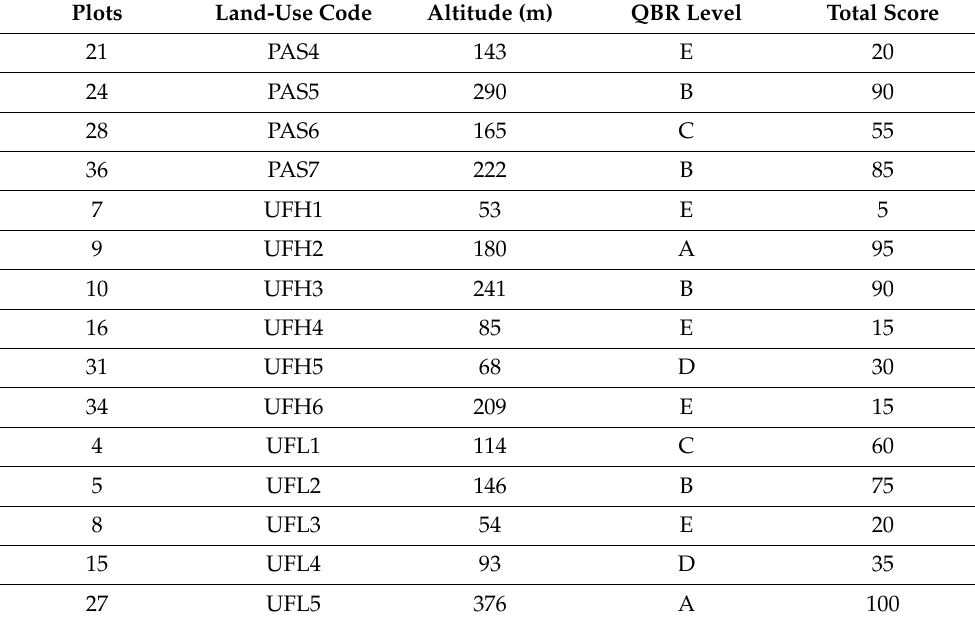
Table 1. Cont. Plots